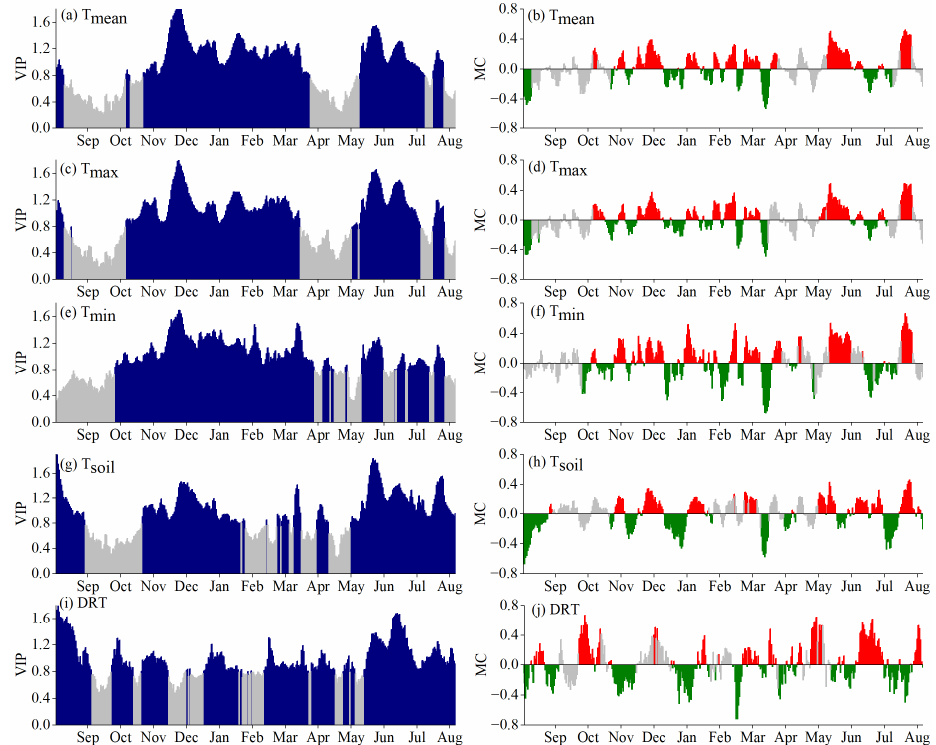
Figure 5. Results of partial least squares (PLS) regression correlating the peak of the growing season (POS) from 1985–2018 with 31-day running means of climatic factors. ( a , b ) Daily mean air temperature (T mean ), ( c , d ) daily maximum air temperature (T max ), ( e , f ) daily minimum air temperature (T min ), ( g , h ) daily surface temperature (T soil ) and ( i , j ) diurnal temperature range (DTR) from the previous September to August of the year.